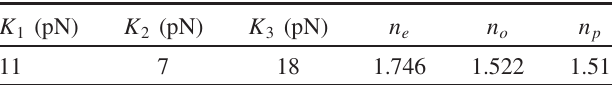
and refractive ; 2 ; 3 is p